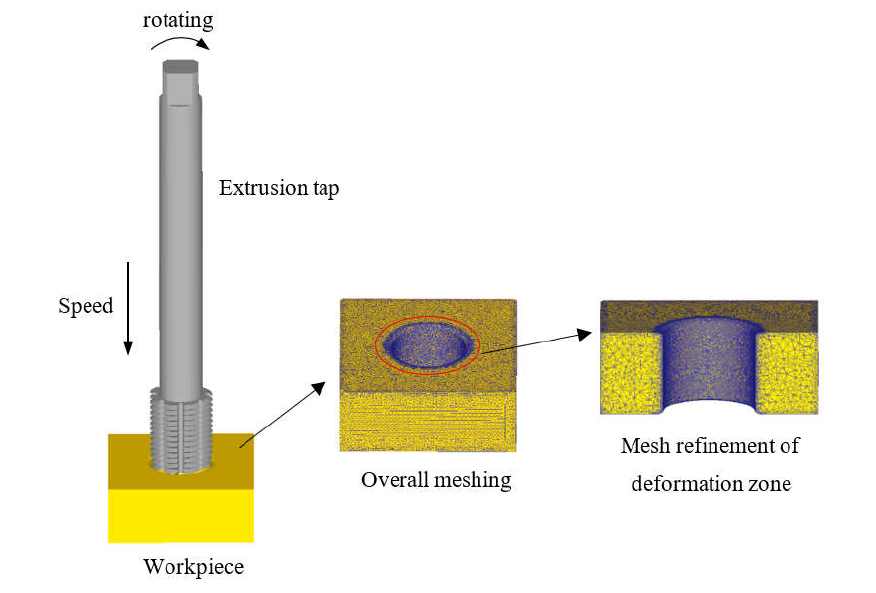
Figure 14. Finite element model of workpiece and